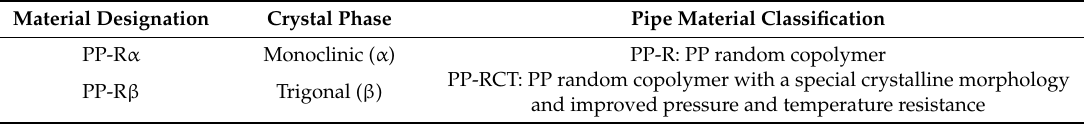
Table 1. Material designation, crystal phase, and pipe material